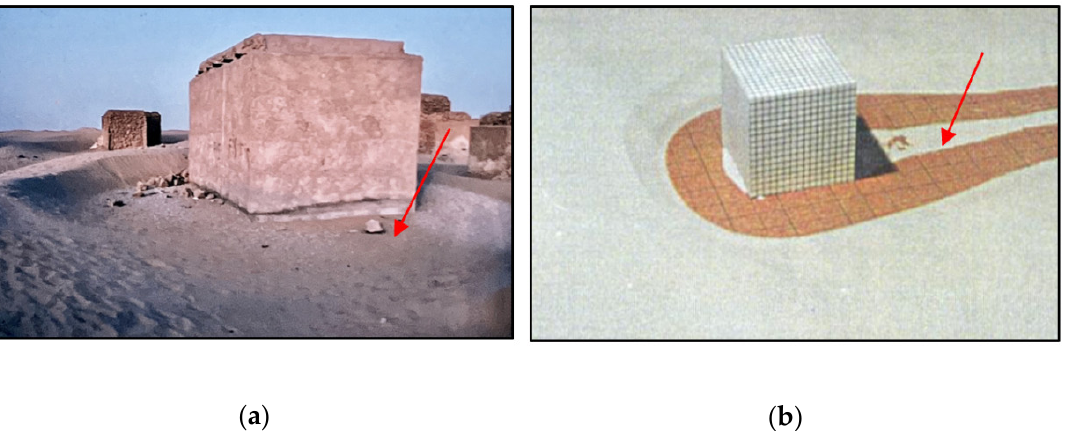
Figure 13. Sand tail developing directly downwind of a building ( a ) in the field and ( b ) simulated in the wind tunnel (photos: M. Sherzad).